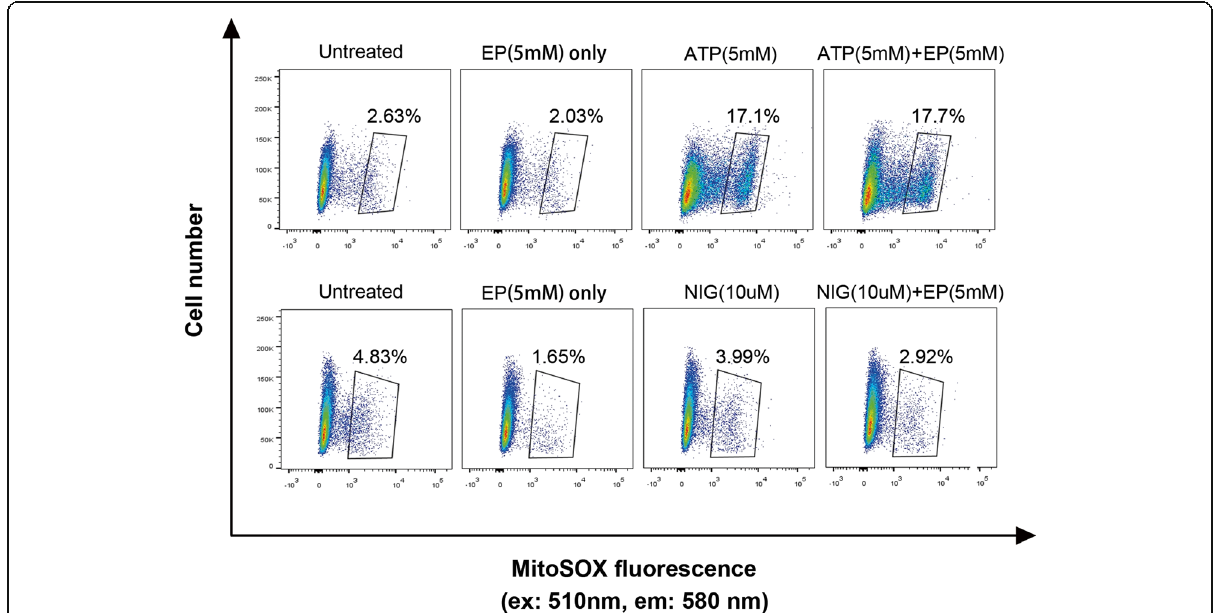
Fig. 6 Ethyl pyruvate does not inhibit NLRP3 agonists-induced mtROS production. MtROS levels were determined by MitoSOX staining of LPS-primed